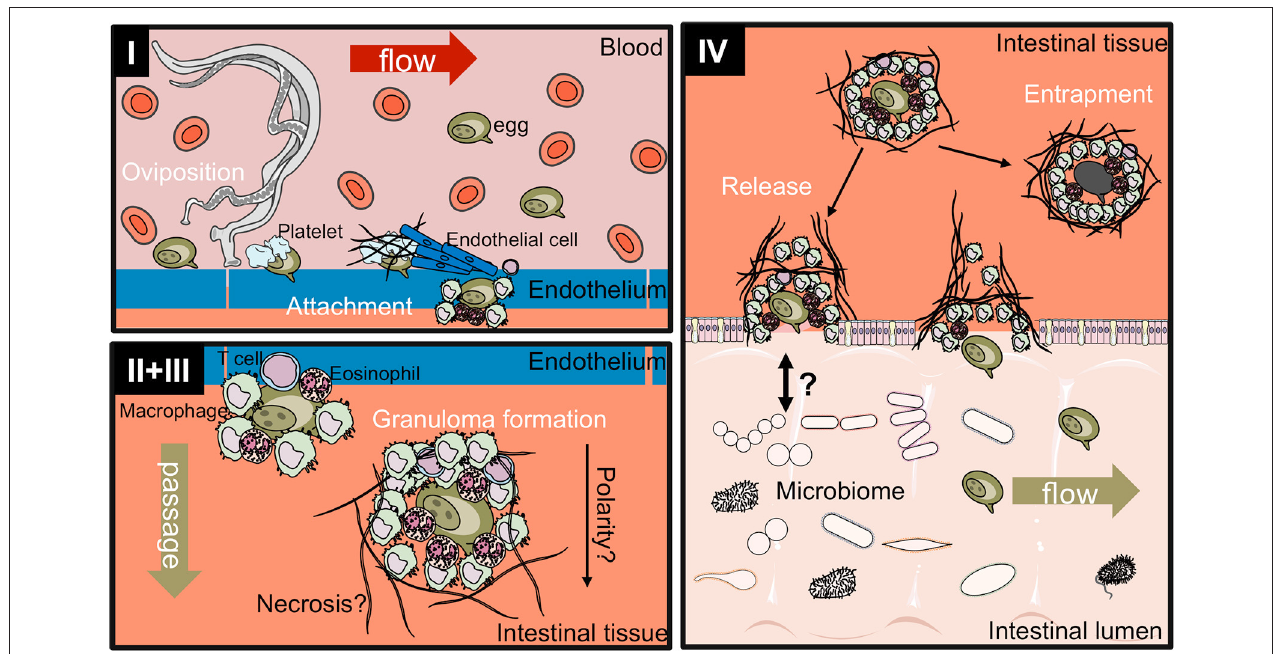
FIGURE 3 | Proposed four-stage process of intestinal egg excretion. I: Adult schistosomes deposit eggs into the vasculature close to the lamina propria. Platelets and fibrinogen adhere to the eggs and activate the endothelium. Endothelial cells actively grow over the egg supporting its extravasation. Eggs that do not cross the endothelial border are disseminated by the blood flow and become trapped mostly in the liver portal system. II + III: Immune cells, such as macrophages, T cells and eosinophils start to encapsulate the egg. Granuloma formation occurs around the egg and together with other processes, such as fibrinolysis, egg secretions-induced necrosis, leads to the passage of the egg toward the intestinal lumen. IV: Entrapped eggs become fibrotic and calcified. Interaction with the microbiome, epithelial cell death and remodeling may lead to the active release of eggs, which are then released to the environment with host feces. Illustrations modified from Servier